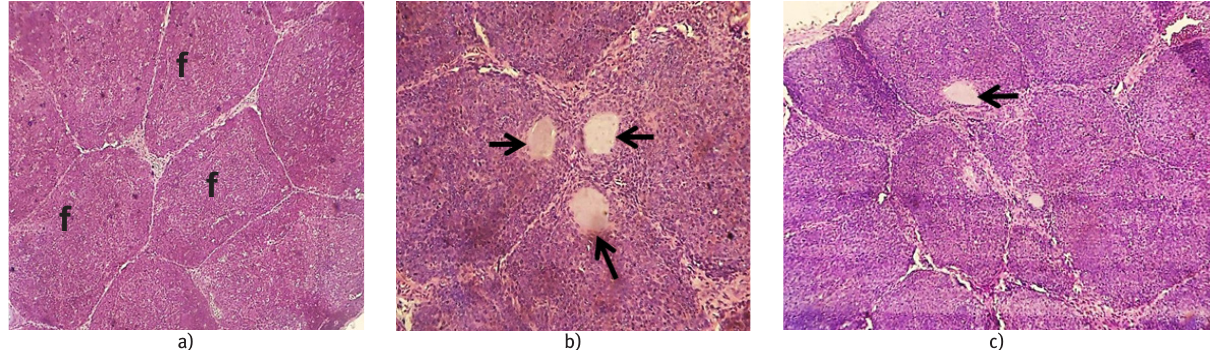
Figure 3: Photomicrograph of section of bursae of pigeons post-inoculation and/or exposure to a very virulent infectious bursal disease virus. Note intact follicles (F) in group A (a); vauolations (arrows) in groups B (b) and C (c) pigeons. H & E x 200